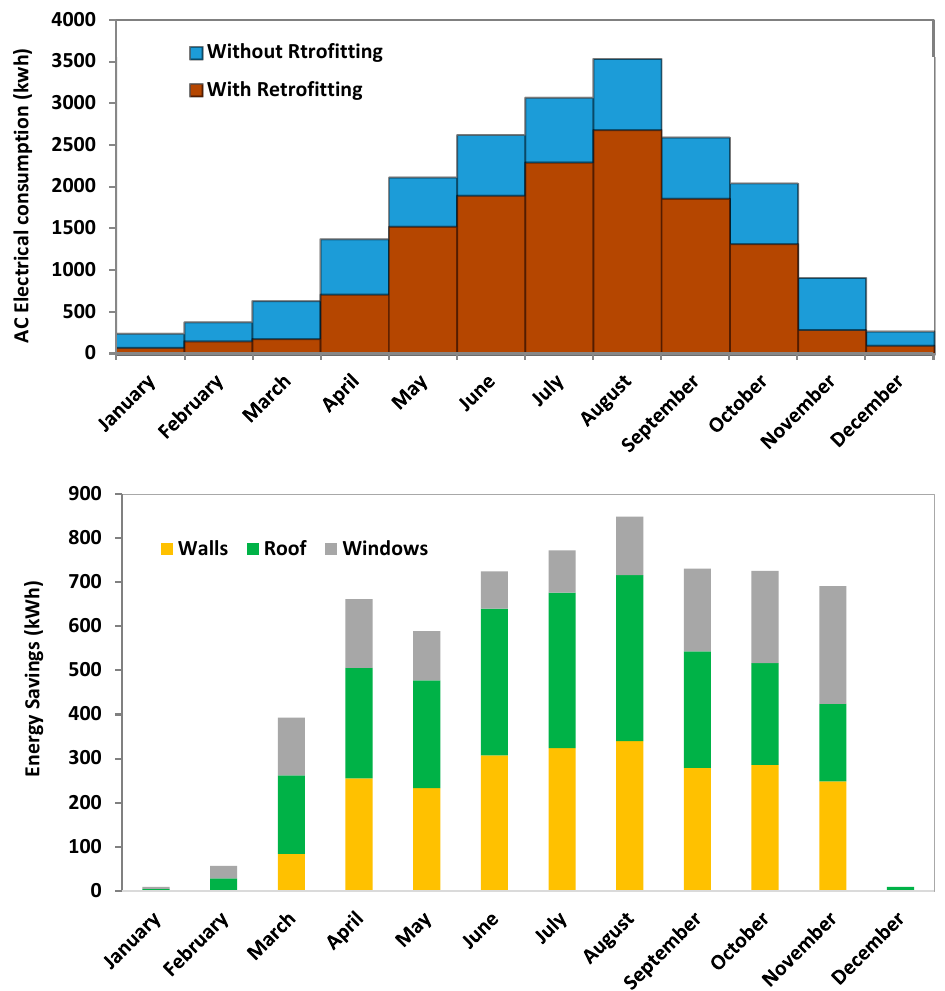
Figure 16. Annual energy savings for a retrofitted townhouse ( top ) with and without retrofits ( bottom ) savings distribution among options considered.